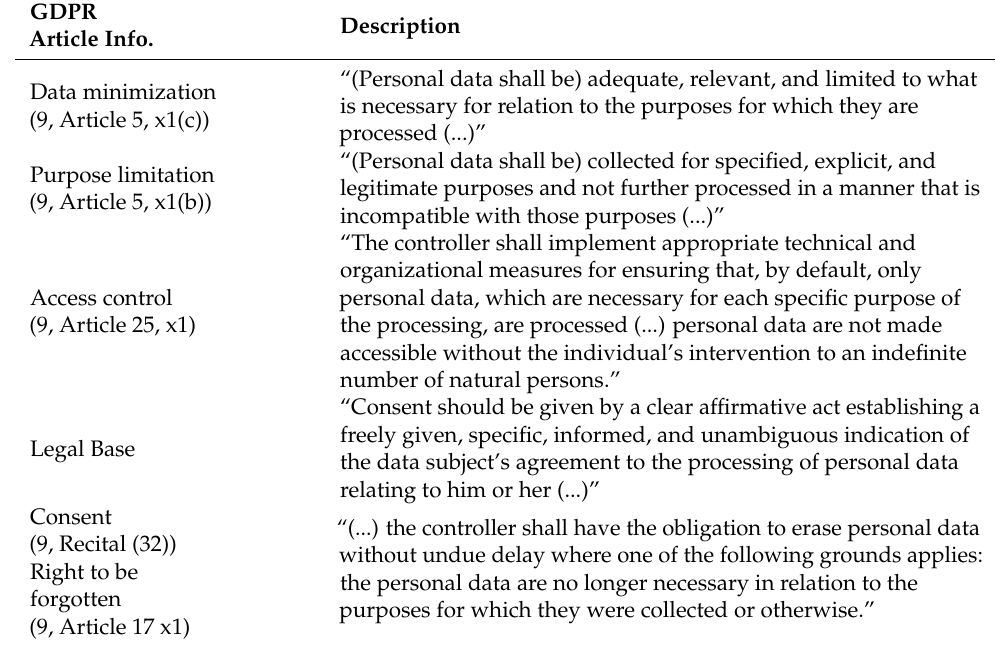
Figure 2. Provenance model. Table 2. GDPR articles supporting purpose limitation.